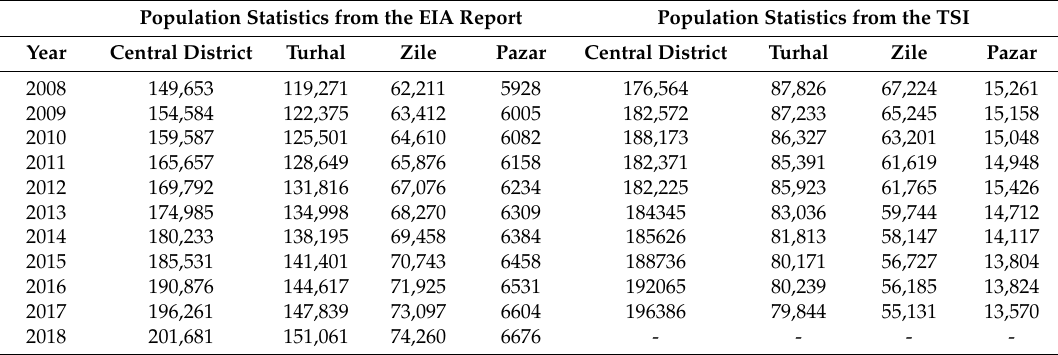
Table 4. Total population statistics for the four districts obtained from environmental impact assessment (EIA) report and Turkish Statistical Institute (TSI). Population Statistics from the EIA